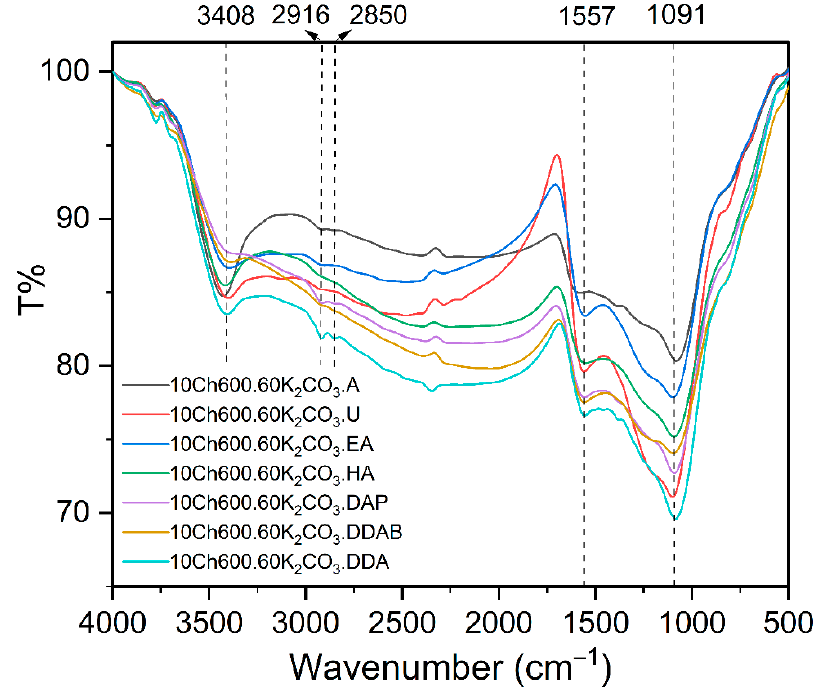
Figure 4. FTIR-spectrum of activated carbon using K 2 CO 3 as activator and different N-rich functional groups as indicated.